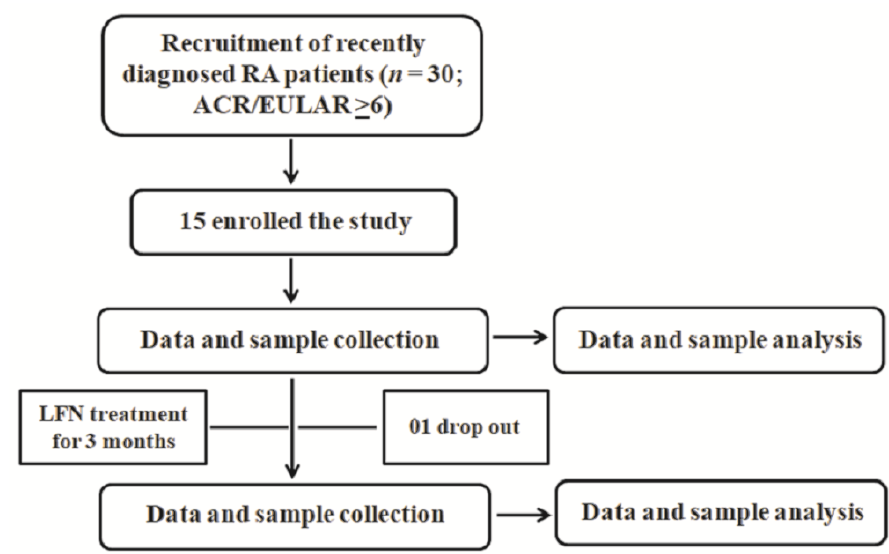
Figure 6. Study workflow. Patients recently diagnosed with RA presenting a score ≥ 6 on the 2010 ACR/EULAR Classification Criteria for Rheumatoid Arthritis, were recruited for participation in the study. All data and blood samples were collected from each rheumatoid arthritis patient at diagnosis (prior to treatment; NST group) and three-months after leflunomide (LFN; 20 mg/day, per os ) treatment. Peripheral blood cells were analyzed by flow cytometry. C-Reactive protein and rheumatoid factor levels were assessed in plasma samples. Plasma samples were also analyzed by attenuated total reflection-Fourier transform infrared (ATR-FTIR) spectroscopy. Data such as gender, age, duration of disease, presence of swollen joints, lumps or deformities, as well as pain and disability scores were collected. Patients presenting with high disease activity scores (Disease Activity Score-28 for Rheumatoid Arthritis with ESR (DAS28-ESR) and Simplified Disease Activity Index for Rheumatoid Arthritis (SDAI) and less than 30% reduction in the visual analog scale (VAS) and Stanford Health Questionnaire-disability index (HAQ-DI) after three-months of LFN treatment were considered as non-responders to LFN. Patients presenting at least a 50% reduction of the disease activity indexes (DAS28-ESR and SDAI) and at least a 30% reduction of the pain and/or disability scores following treatment were considered as LFN-R.